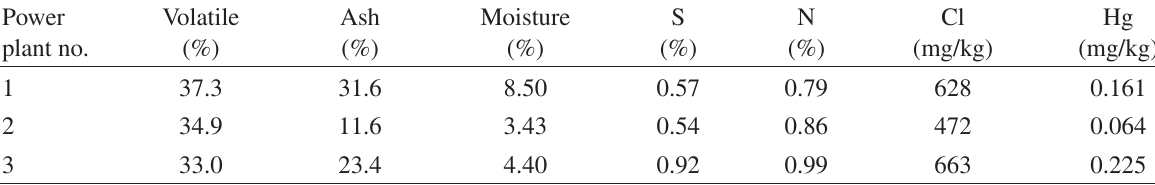
TABLE 6: Major components of coals in three power plants (dry air